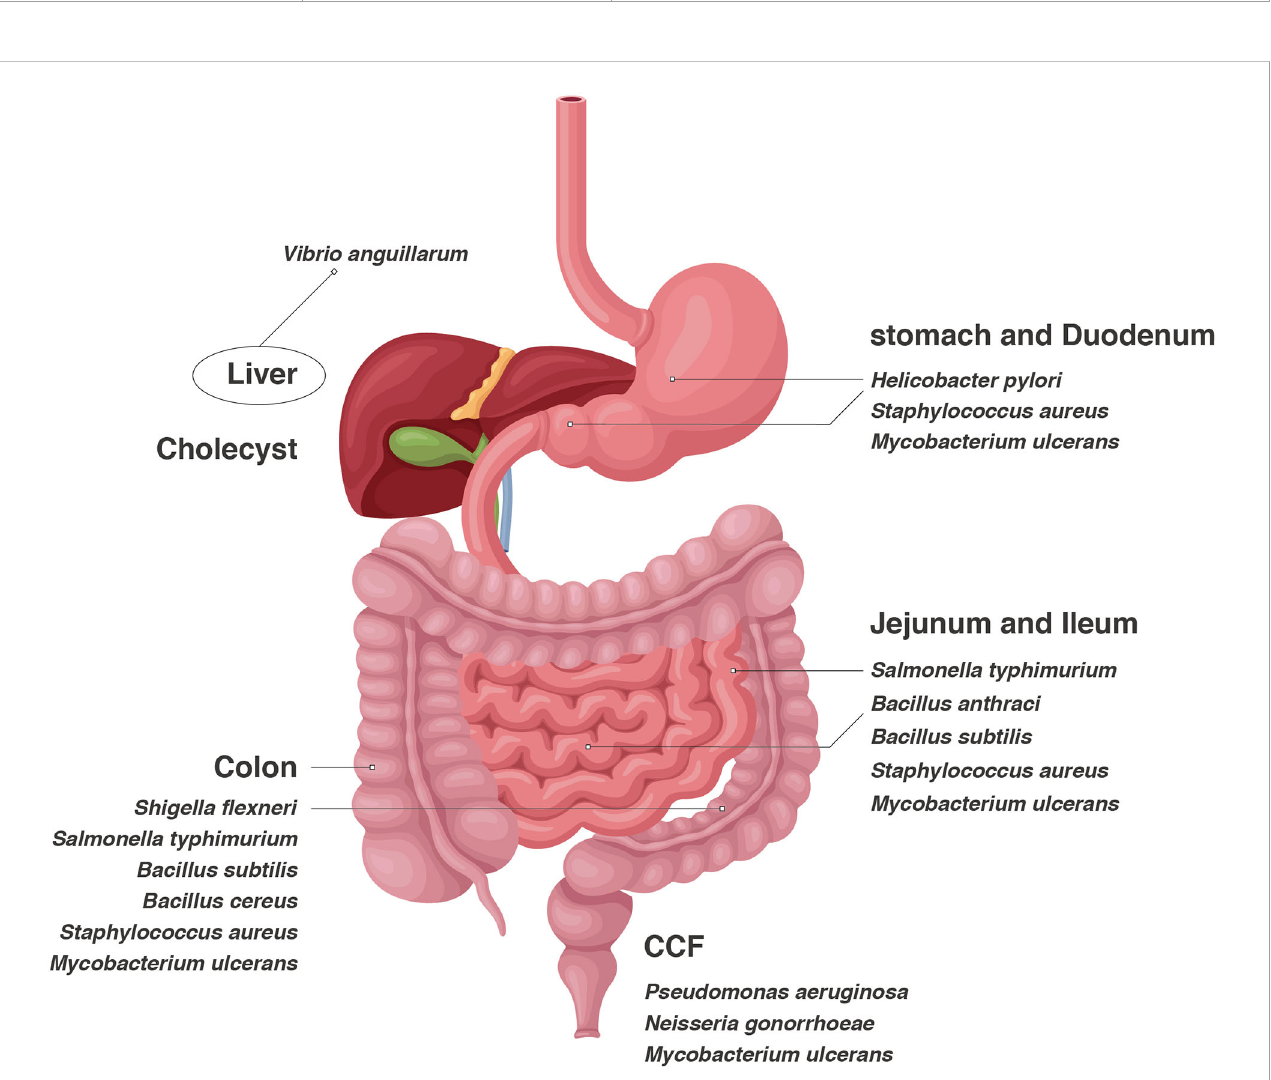
FIGURE 1 Bacteria are distributed in the whole digestive tract, and different bacteria tend to reside in speci fi c